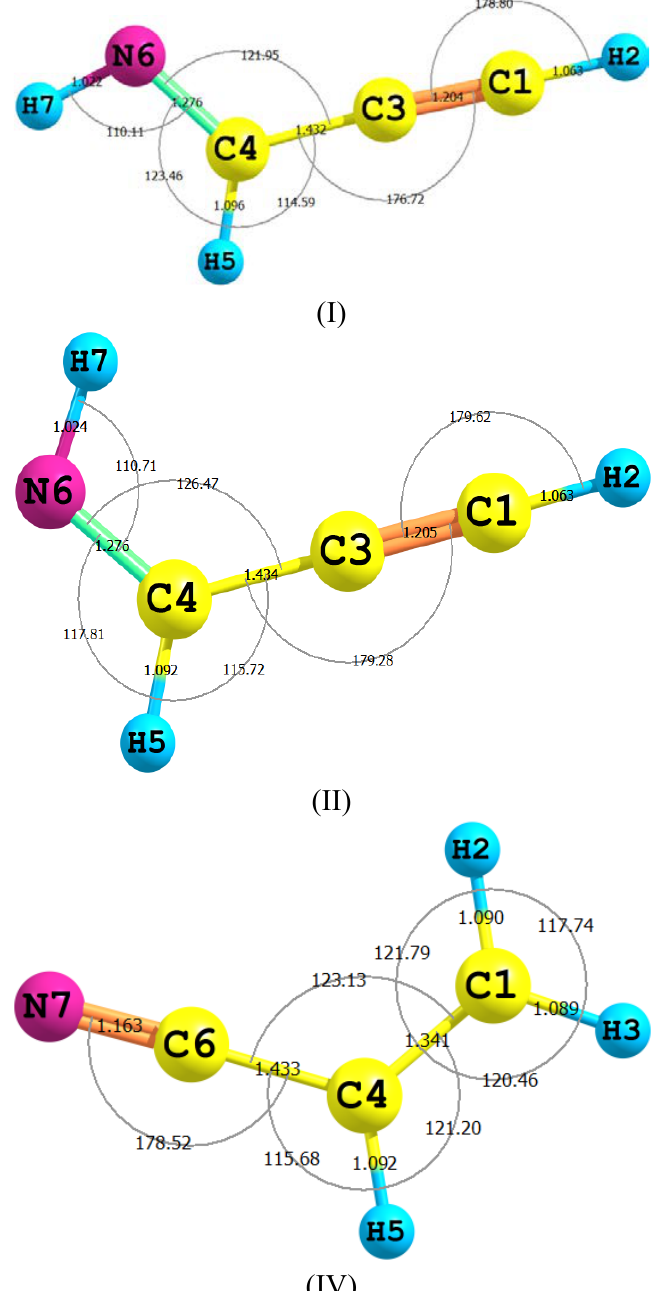
Figure 1. The numbering of atoms for E-prop-2-ynylideneamine (I), Z-prop-2-ynylideneamine (II) and vinyl cyanide (IV), together with their optimized bond lengths (Å) and angles (degrees) using B3LYP/aug-cc-pvdz level of